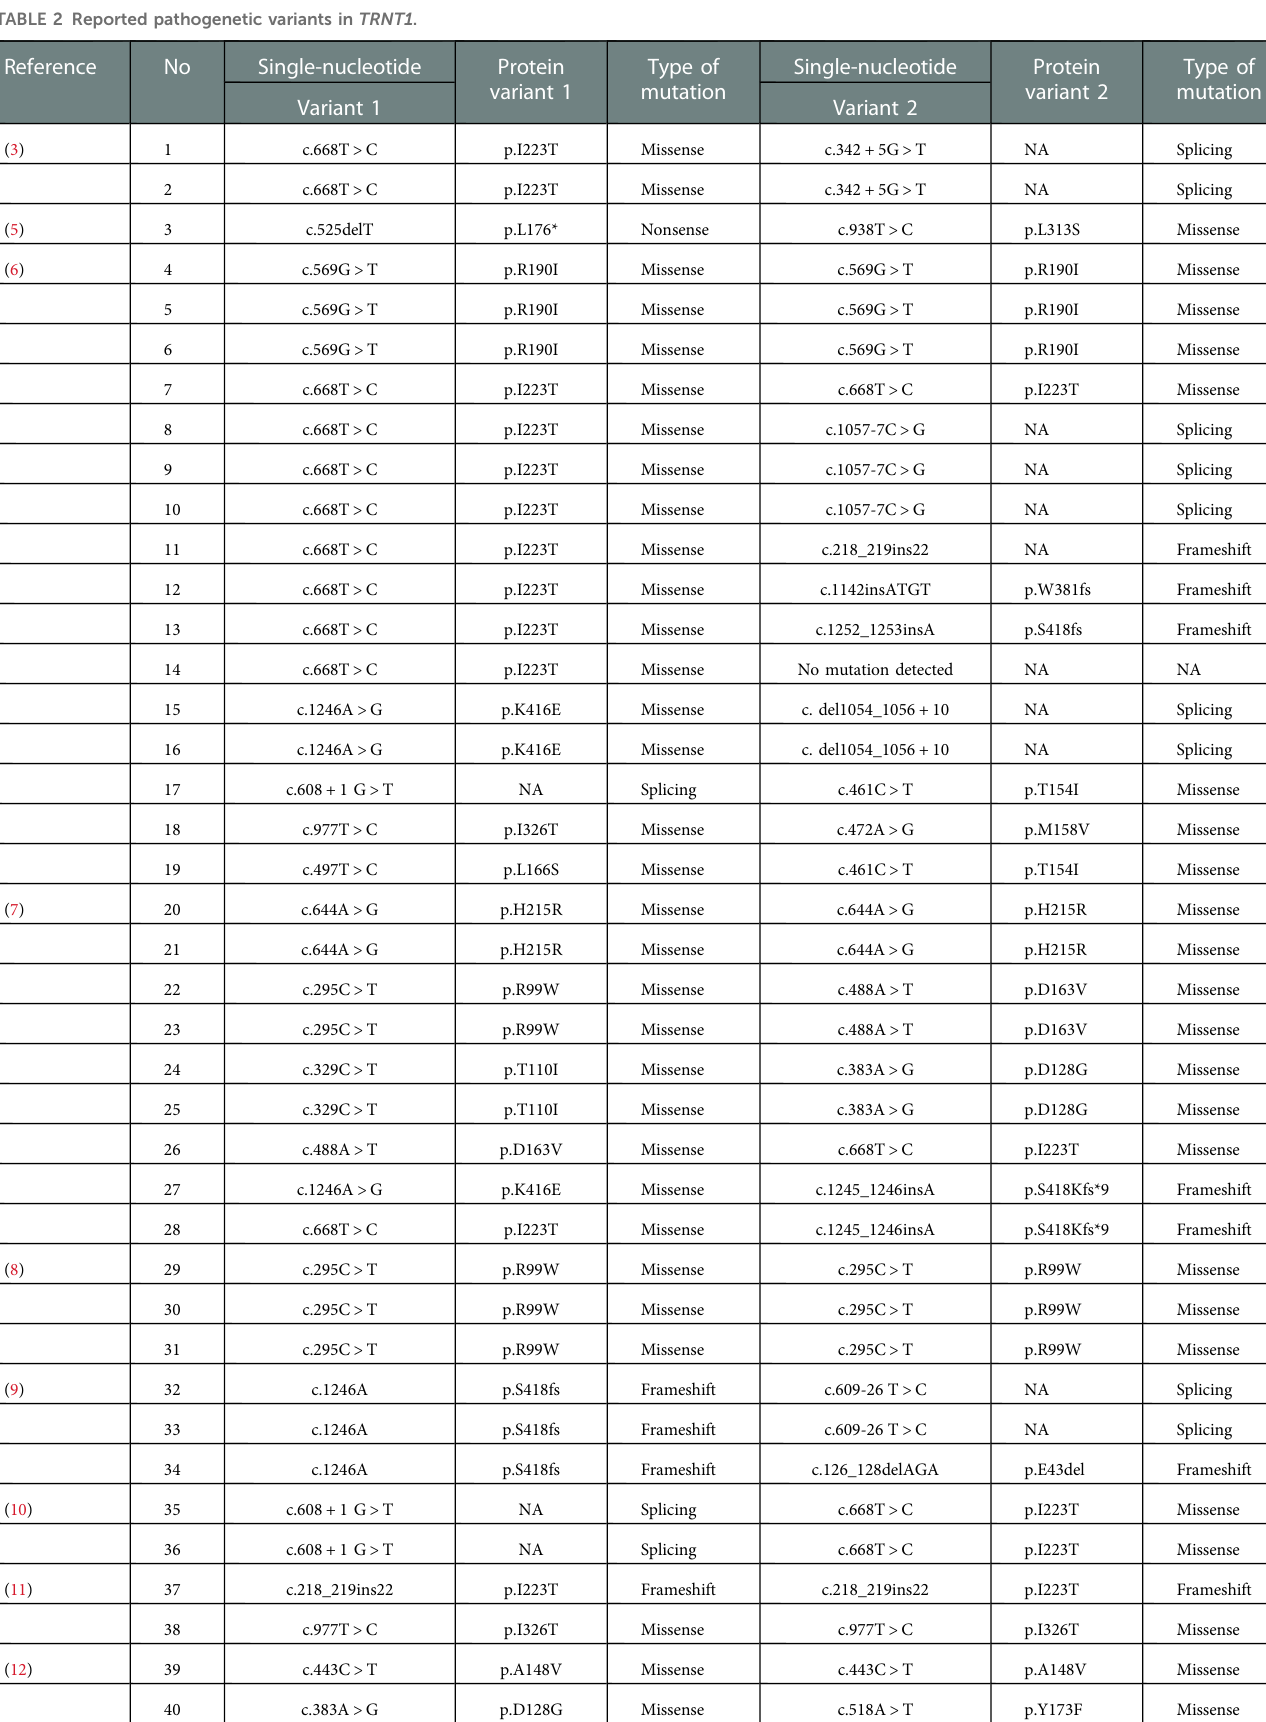
TABLE 2 Reported pathogenetic variants in TRNT1